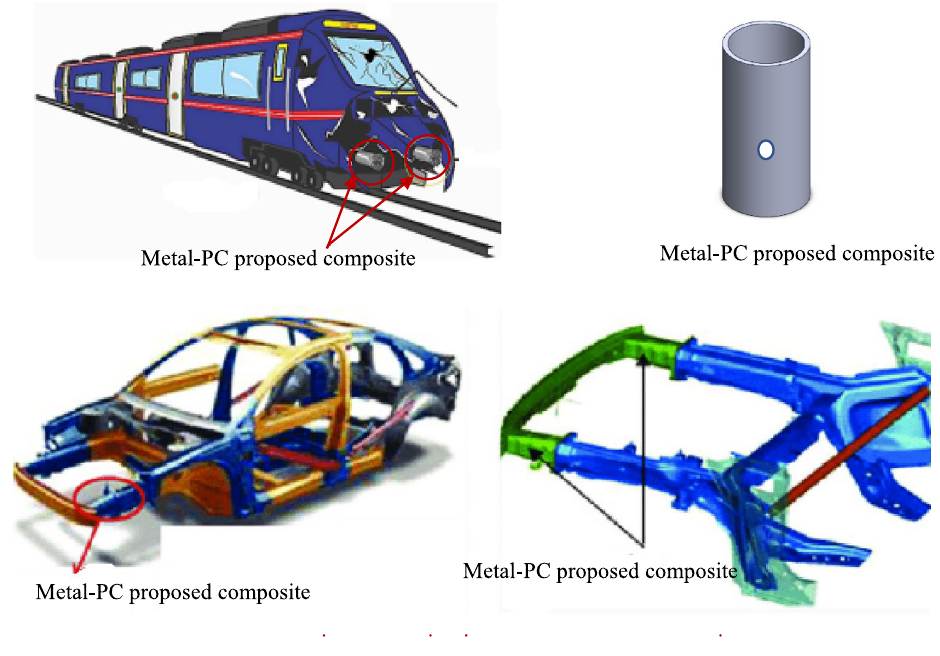
Figure 9. Applications of the proposed